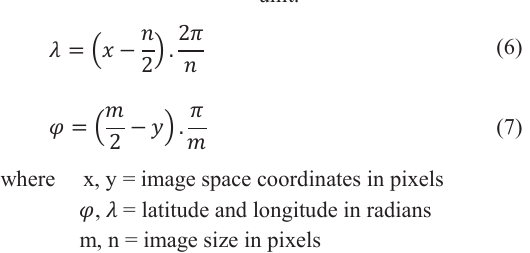
Figure 3. Coordinate systems, (a) image space coordinate system in pixel unit, (b) spherical coordinate system in radian unit.